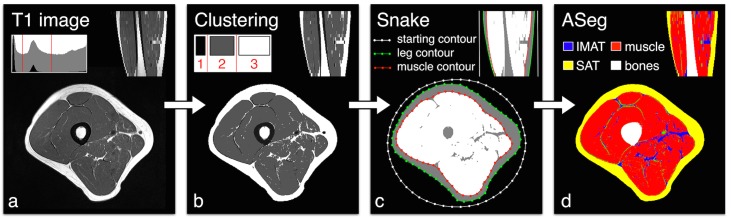
Steps of the automated segmentation algorithm.